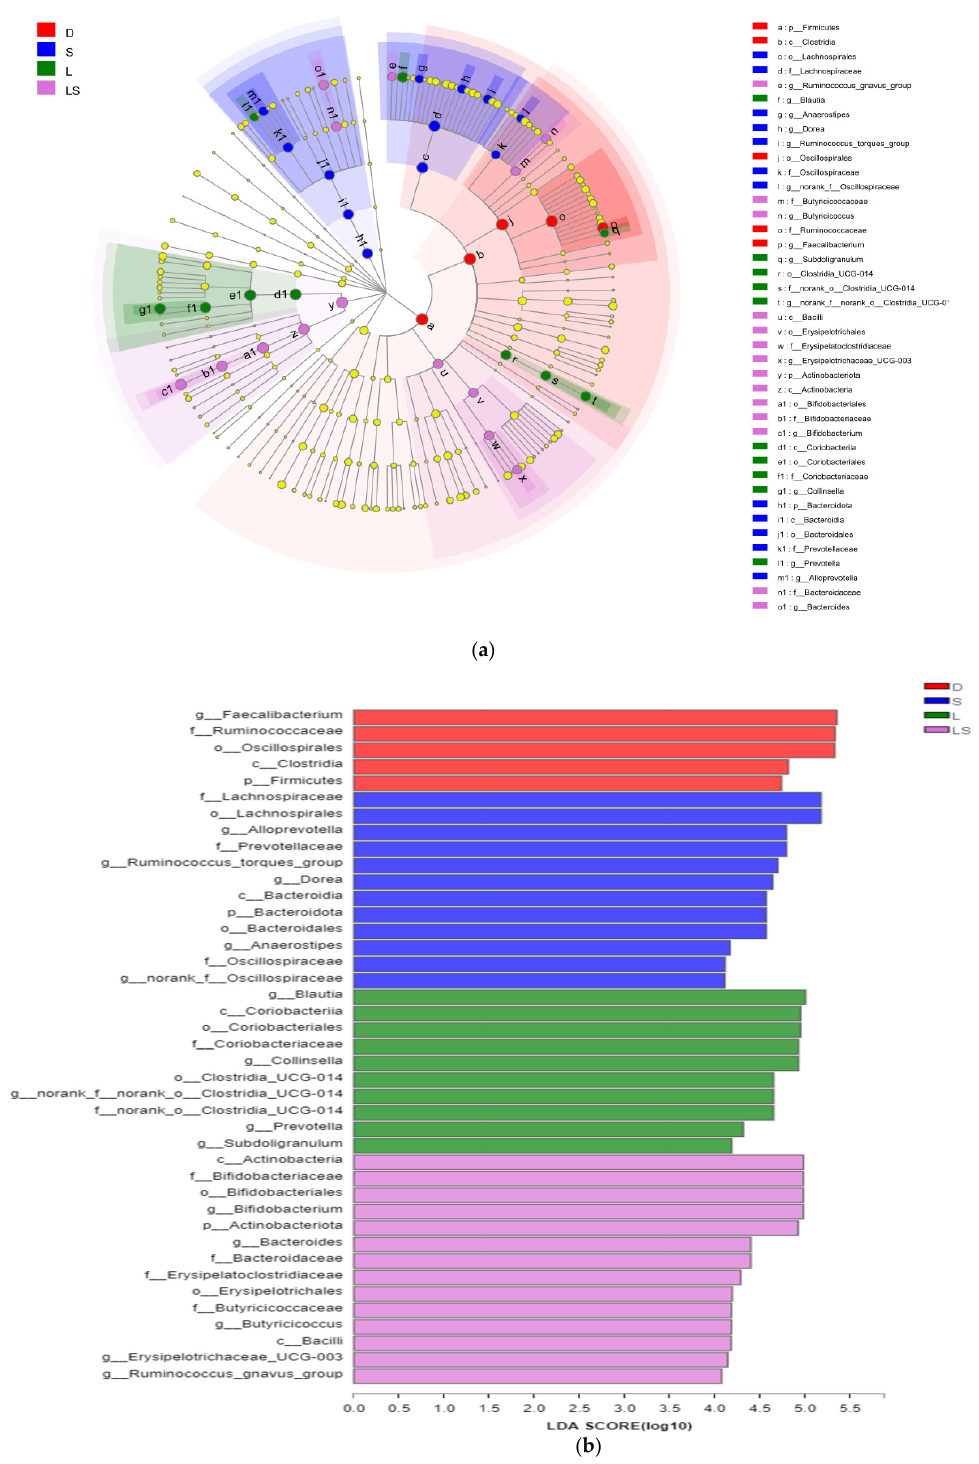
Figure 5. The OTU tables were used on by a linear discriminant analysis effect size algorithm’s consequences to decide the taxa best characterizing each biological class. ( a ) A cladogram that shows bacterial lineages’ phylogenetic distribution in newborn calves from the dissimilar probiotic groups. Different constituents are represented by different colored regions (purple, LS; blue, S; green, L; red, D). Phylogenetic levels are indicated by the circles from the genus level (outer circles) to the phylum level (inner circle). ( b ) LDA scores of the operational taxonomic units in calves from the different probiotic groups. LS group: lactic acid bacteria + yeast group; L group: lactic acid bacteria group; S group: yeast group; D group: control group.